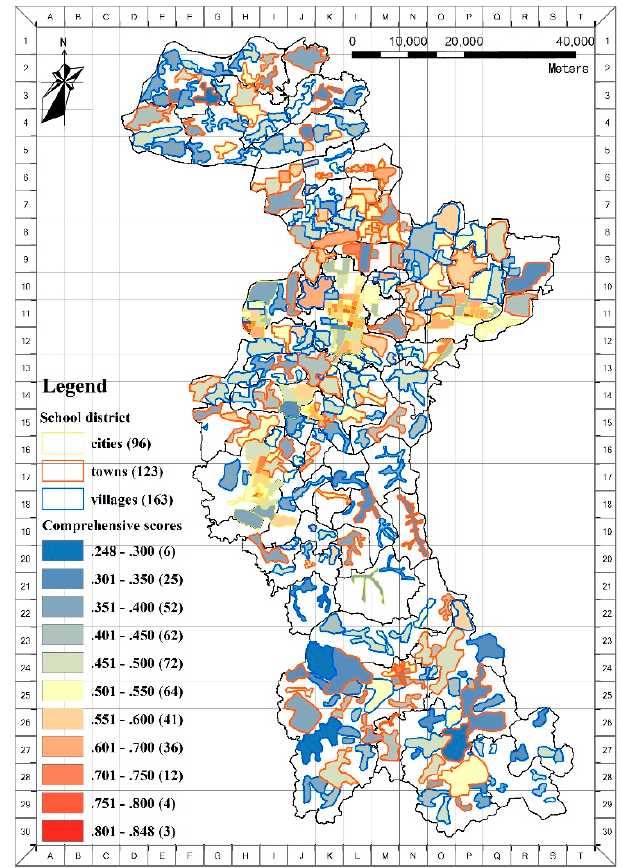
Figure 4. The distribution of comprehensive scores in Zibo City.